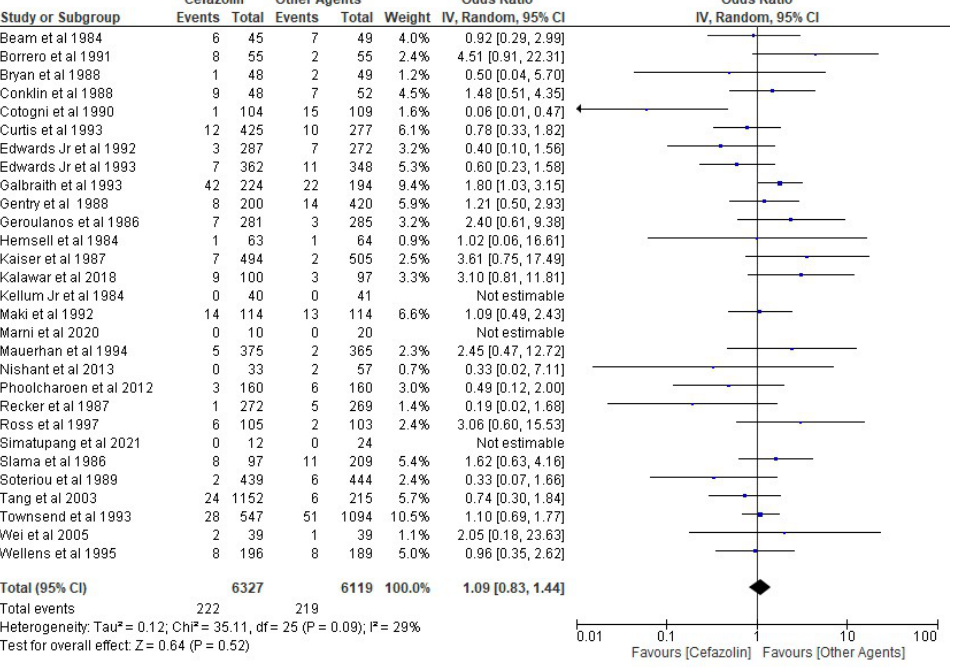
Figure 3. The rate of SSIs in the cefazolin group vs. cefuroxime group. The included studies were Borrero et al. 1991 [29], Conklin et al. 1988 [33], Cotogni et al. 1990 [30], Curtis et al. 1993 [24], Ed- wards Jr et al. 1992 [28], Galbraith et al. 1993 [26], Gentry et al. 1988 [34], Geroulanos et al. 1986 [37], Mauerhan et al. 1994 [23], Nishant et al. 2013 [17], Slama et al. 1986 [38], Tang et al. 2003 [20], Townsend et al. 1993 [27], Wellens et al. 1995 [22].